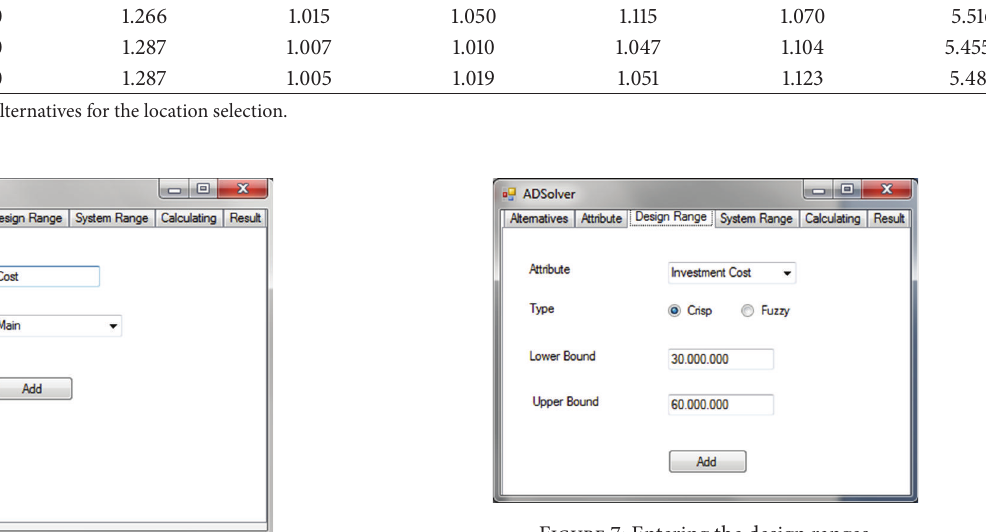
Figure 7: Entering the design